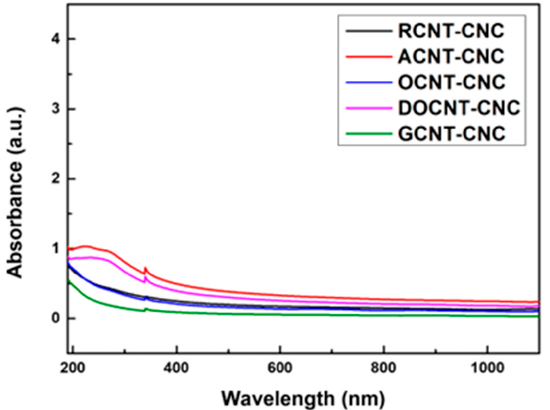
Figure 9. UV–Vis spectra measurement for the dispersion of MWCNT–CNC nanofluids.